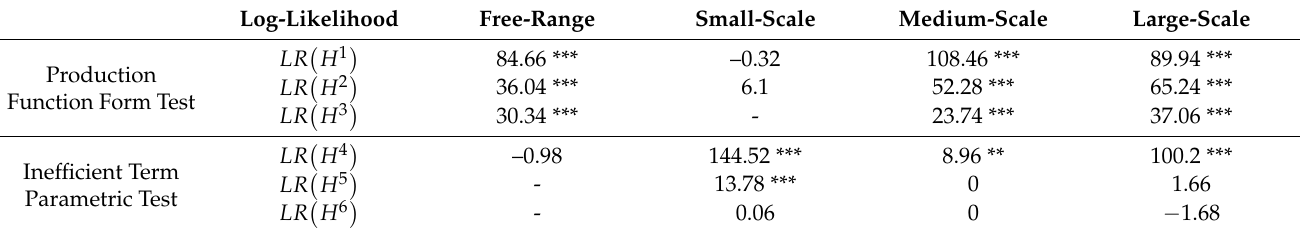
Table 3. Parameter test results of SFA.